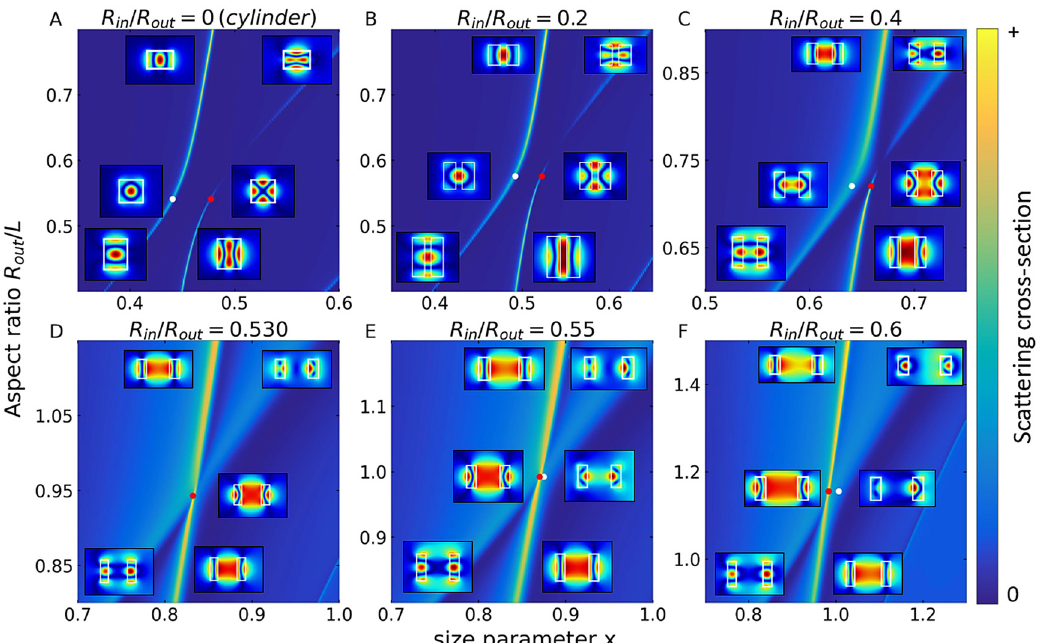
Figure 5: General view of SCSs and field patterns. ∕ L and normalized size Dependencies of the SCS ( m = 1) of cylindrical (A) and ring (B)–(F) dielectric resonators on the aspect ratio R out 𝜔 ∕ c = 2 𝜋 R ∕ 𝜆 for TE-polarized incident waves. The calculations are carried out with the R ∕ L step of 0.02. parameter (frequency) x = R out out out Inserts: the calculated field patterns (total electric field amplitude | E | in the ( x , z ) cross-sections (resonator side view) for the high-frequency ∕ L values – two and TM . The field distributions are shown for three R and low-frequency branches of the interacting pair of modes TE 1 , 1 , 0 1 , 1 , 1 out ∕ L value corresponding to the quasi-BIC. Quasi-BIC points are marked with red dots, extreme ones, shown on each of the panels and the R out ∕ L value on a different branch are marked with white and points corresponding to the same R out